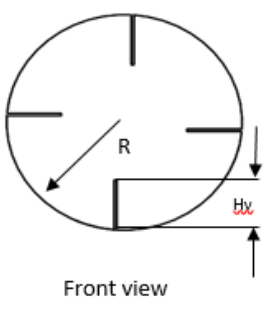
Figure 5. Design of GVD.